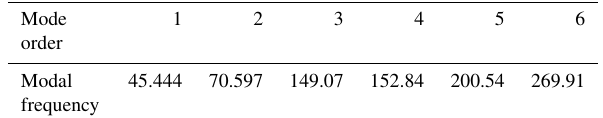
Table 4. The sixth-order modal frequencies of the frame (Hz).